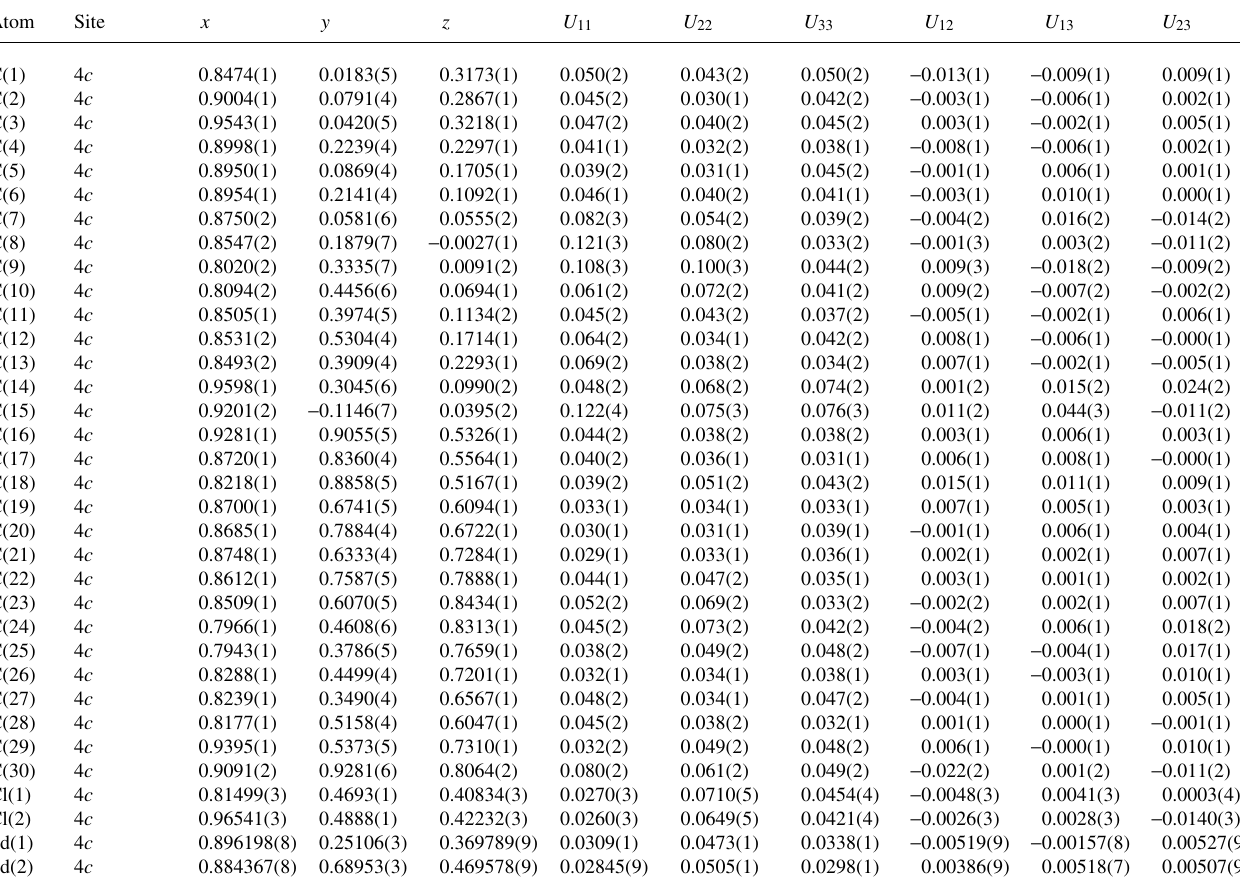
Table 3. Atomic coordinates and displacement parameters (in Å 2 ) .